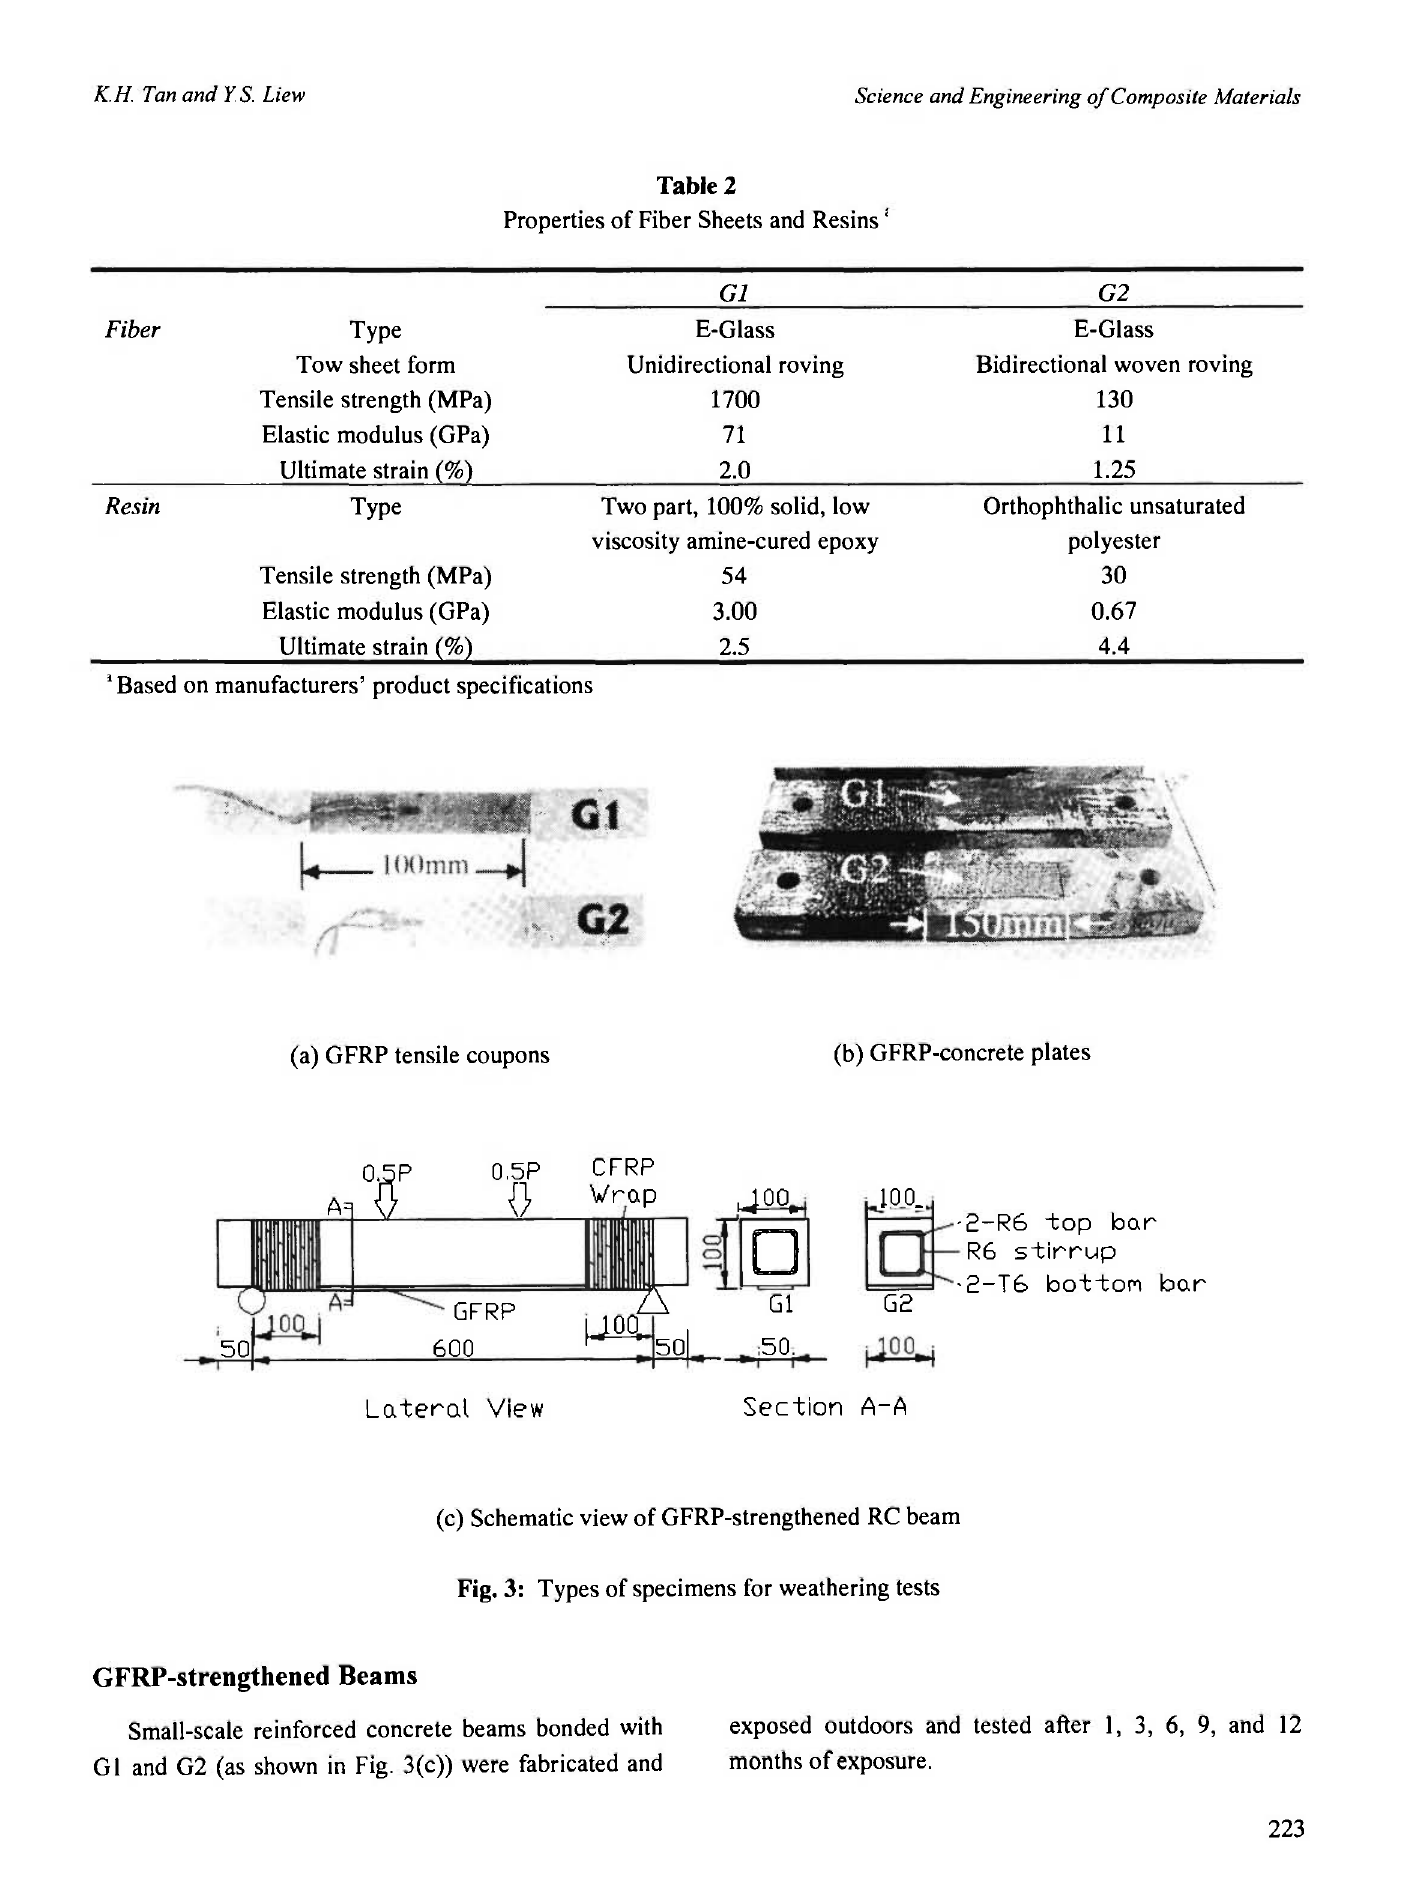
exposed outdoors and tested after 1, 3, 6, 9, and 12 months of